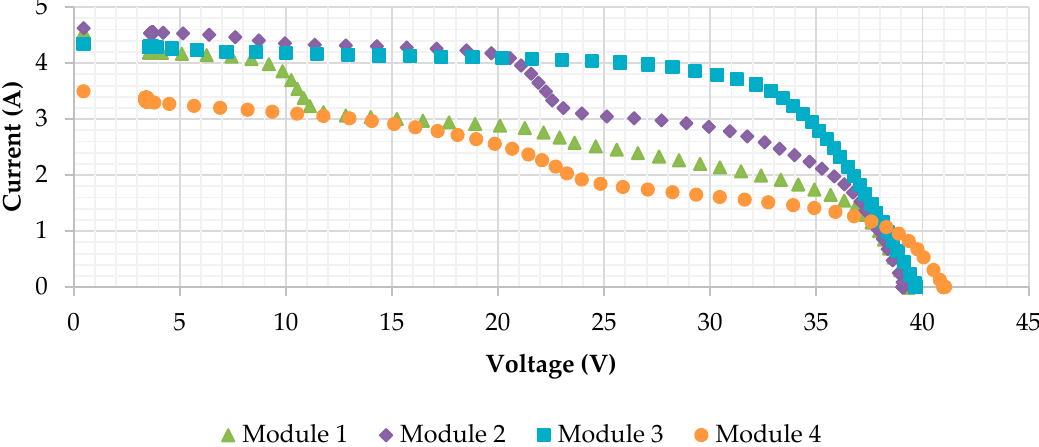
Figure 8. I-V curves of the 175W Eoplly mono-crystalline defective modules analyzed in the research, drawn using an I-V tracer Solar IV HT 1500V at 800, 859, 839 and 792 W / m2 for modules 1 to 4, respectively. Typical knees of the operation of the bypass diode can be observed in the I-V curves.